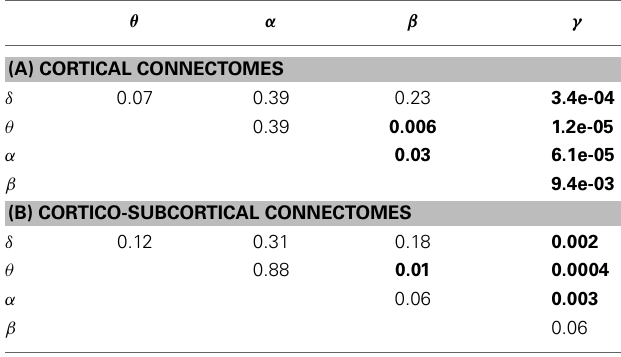
Table 1 | P -values of Wilcoxon rank-sum test for assessing differences between intra-subject comparisons of EEG and fMRI across bands (WTS) shown in Figure